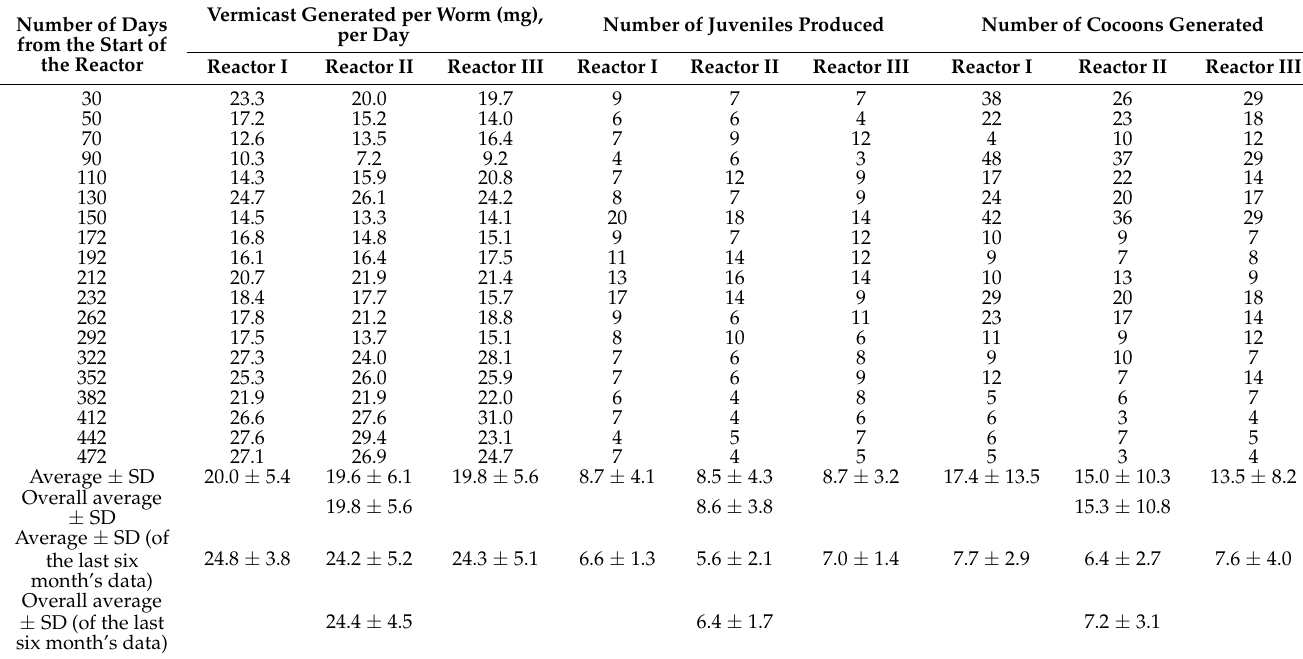
Table 4. Vermicomposting of lantana with 80 adults of E. fetida per kg of feed in pulse-fed